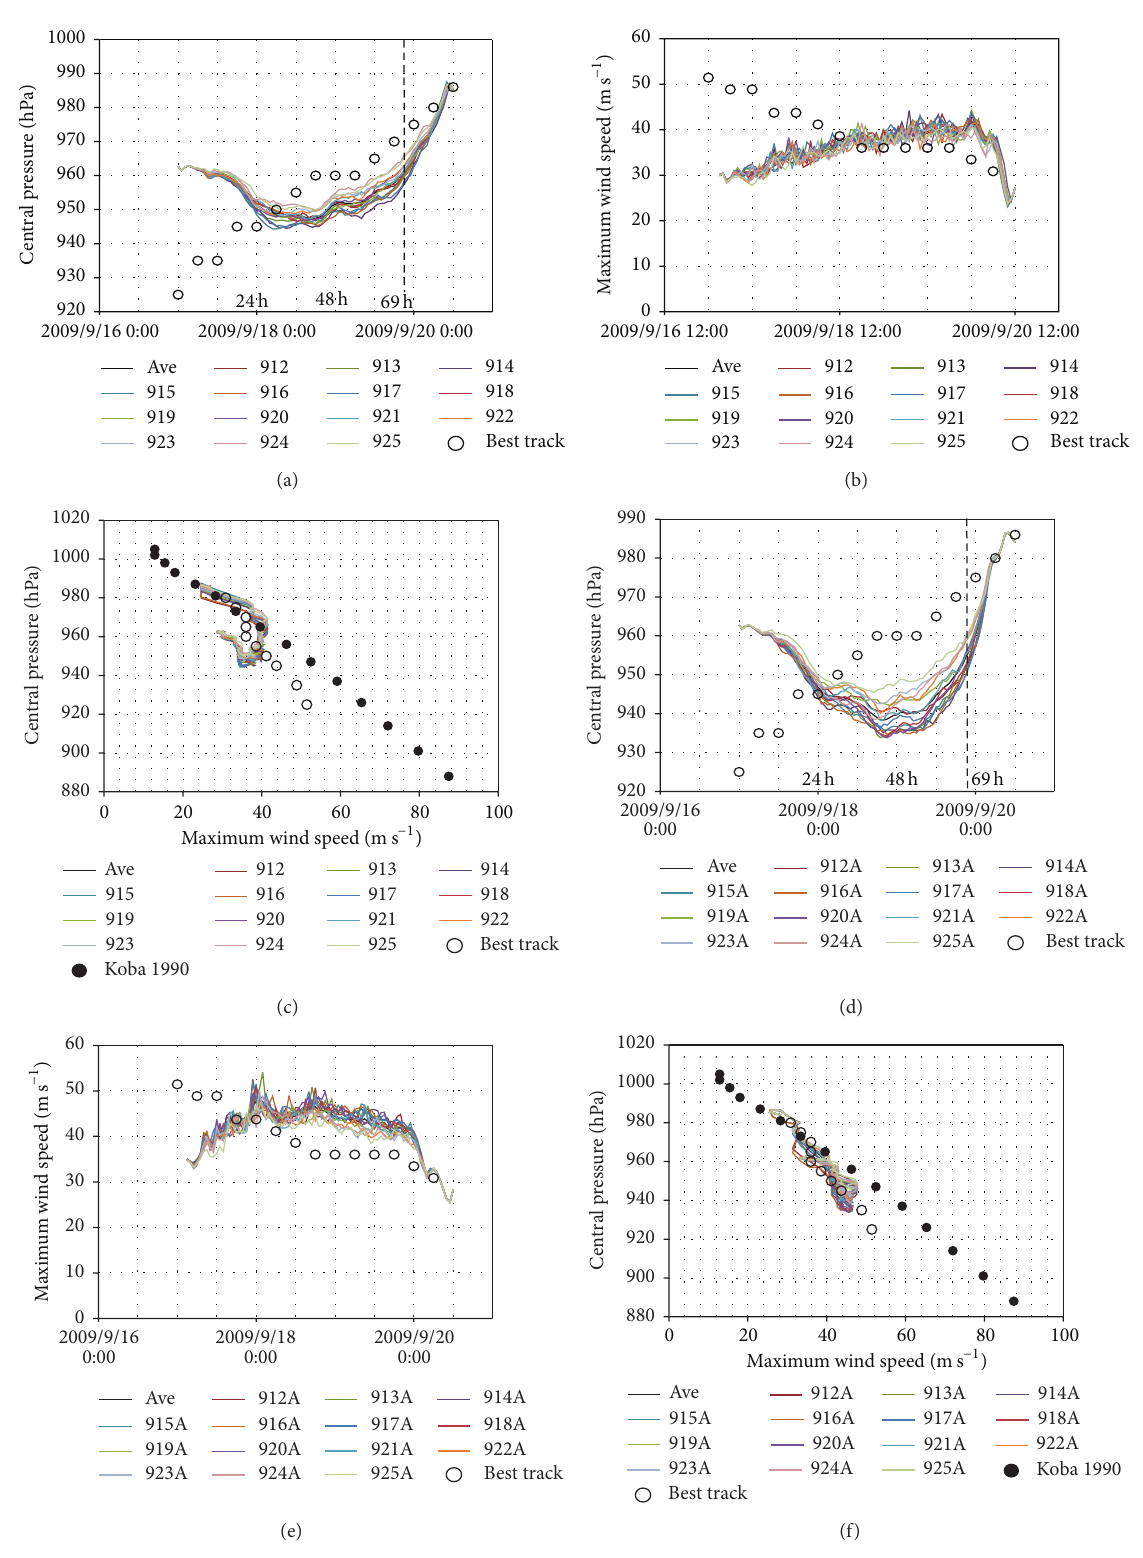
Figure 4: Time series of (a) central pressure and (b) maximum wind speed, showing the six-hourly best-track values, the hourly value in each simulation, and the mean hourly simulated value of the 14 simulations. Integration times at 24 h, 48 h, and 69 h are included in the intensification, mature, and decaying phases, respectively. (c) The wind-pressure relationship simulated by the coupled model in each experiment and in the best-track data. The relationship proposed by Koba et al. [30] is shown for comparison. (d)–(f) Same as (a)–(c), except showing the simulation results of the uncoupled atmosphere